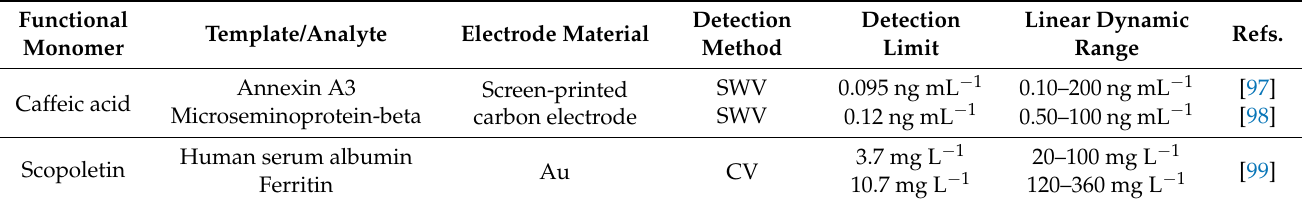
Table 4. Figures of merits of the sensors with protein-imprinted polymers based on the natural phenolic antioxidants. Functional